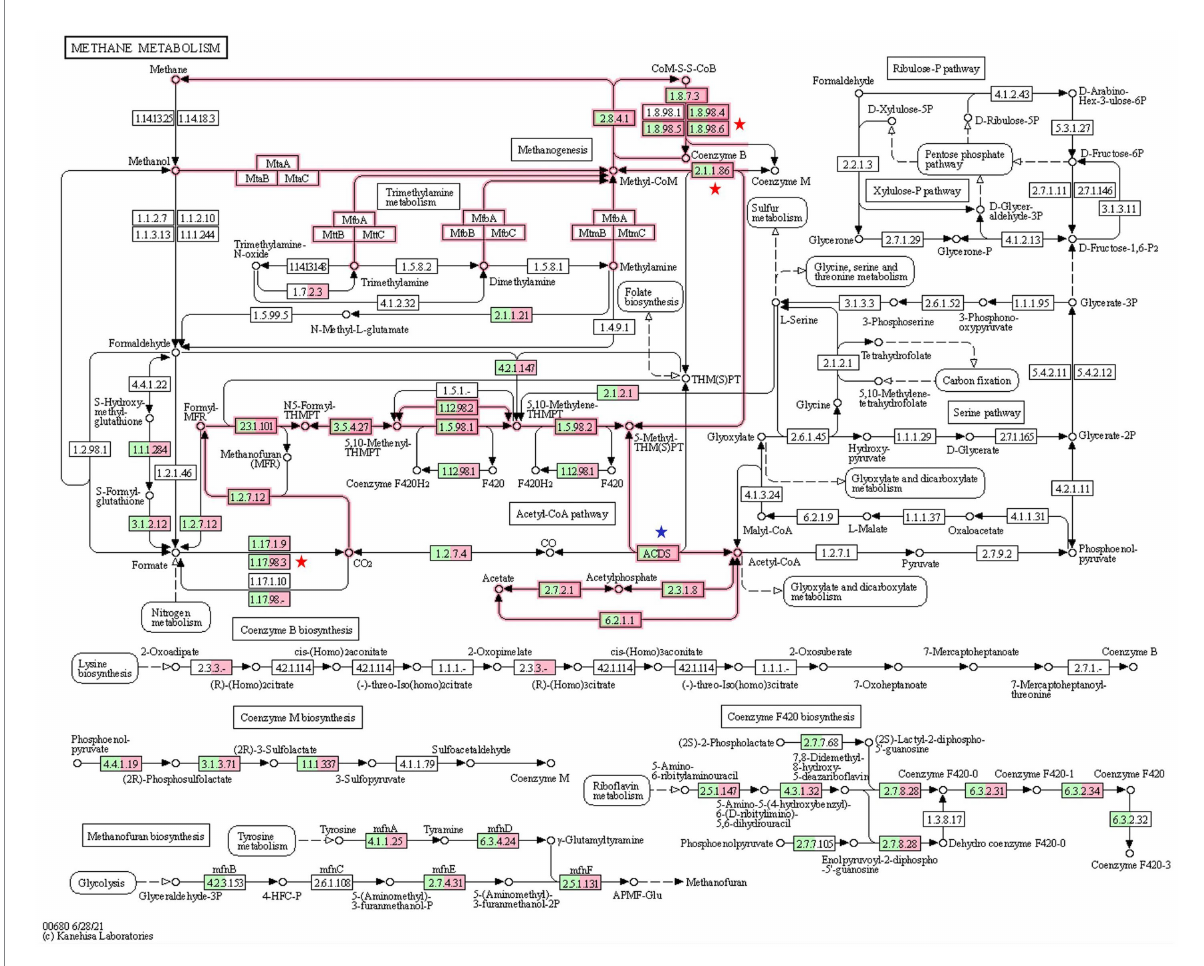
FIGURE 6 KEGG analysis for methanogenesis pathways. The numbers in the boxes represent the EC numbers of enzymes involved in methanogenesis pathways. The green color inside the box represents relative genes from the CON group microbiome, while the box in pink refers to the relative genes from the HD treatment group. At several steps in the pathway, genes related to methane metabolism has been significantly reduced in the HD treatment group. KO numbers and gene annotation of the enzymes are shown in Supplementary